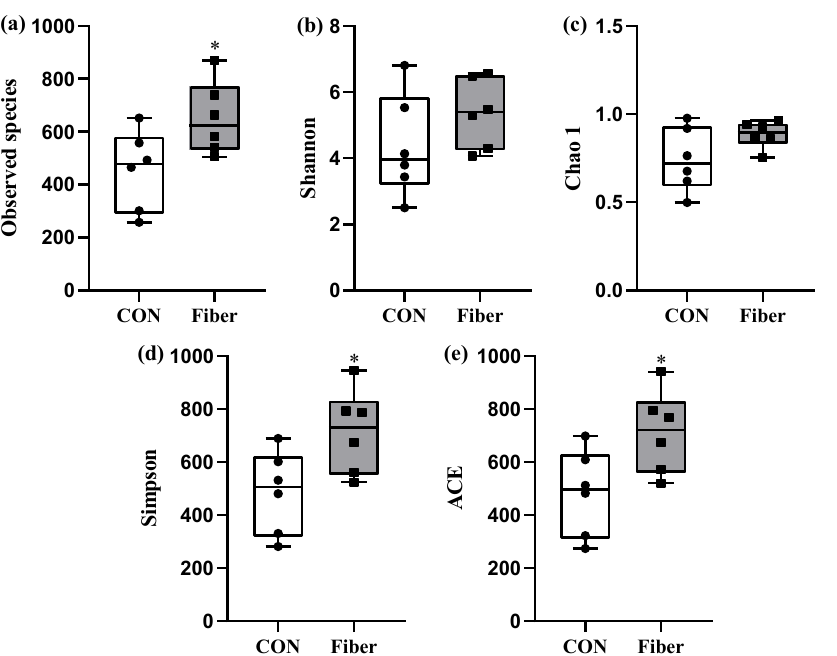
Figure 5. Differences in bacterial community diversity and richness in the two groups. ( a ), Observed species; ( b ), Shannon; ( c ), Chao 1; ( d ), Simpson; ( e ) ACE. Values are presented as box-and-whisker plots, * means p < 0.05.